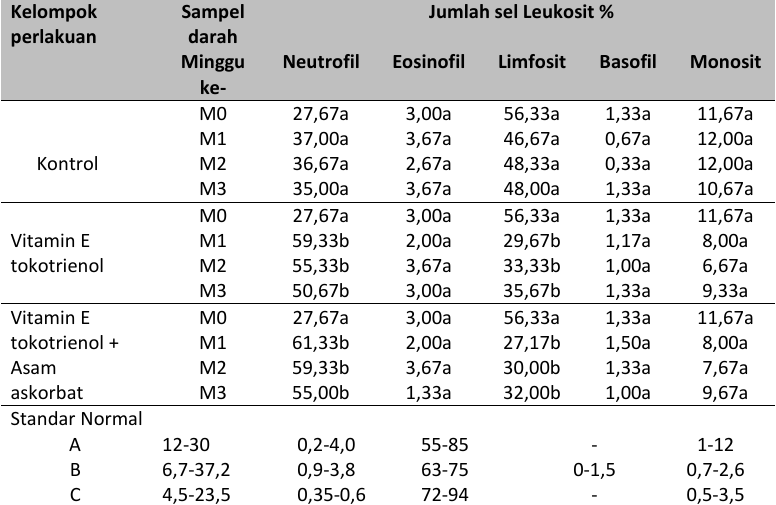
Tabel 1. Rerata persentase jumlah sel leukosit dari semua kelompok tikus